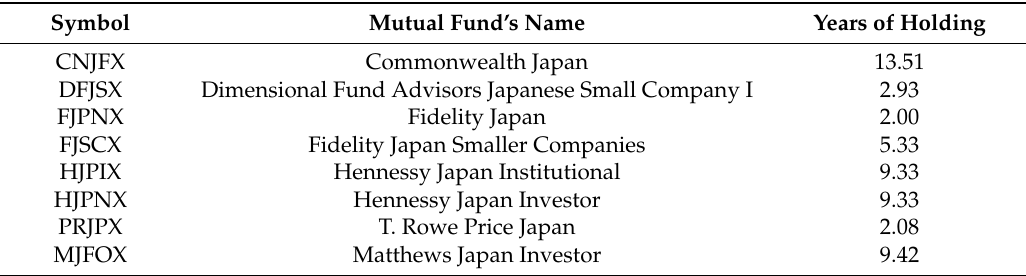
Table 1. Mutual funds’ symbols and years of